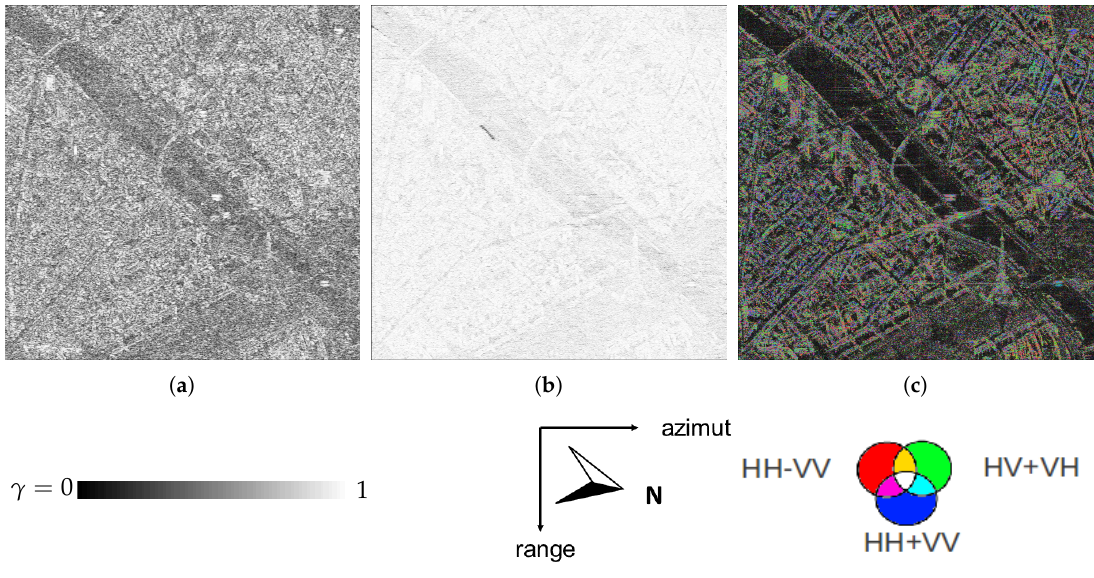
Figure 10. Impact of the coherence optimization and optimum mechanisms ( a ) Interferometric coherence level in HH; ( b ) Interferometric level in optimal basis; ( c ) Colored composition where colors code the component magnitudes of the optimal